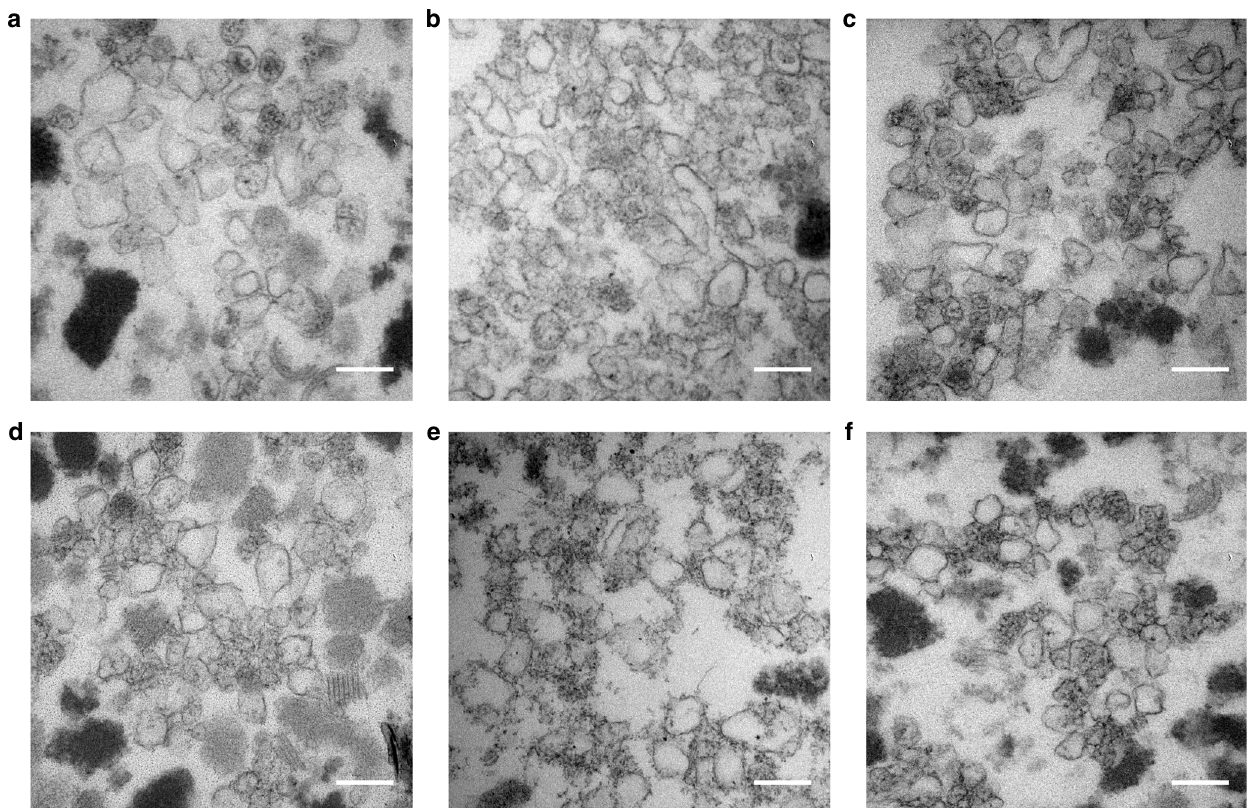
Fig. 1 TEM analysis of resin embedded, thin-sectioned, puri fi ed BMCs. BMCs extracted from E. coli BL21 * (DE3) cells expressing the following modi fi ed PduA proteins. a CC-Di-A-PduA-U. b CC-Di-B-PduA-U. c C-PduA-U. d CC-Di-A-Citrine-PduA-U. e CC-Di-B-Citrine-PduA-U. f C-Citrine-PduA-U. Scale bars show 0.2 µ